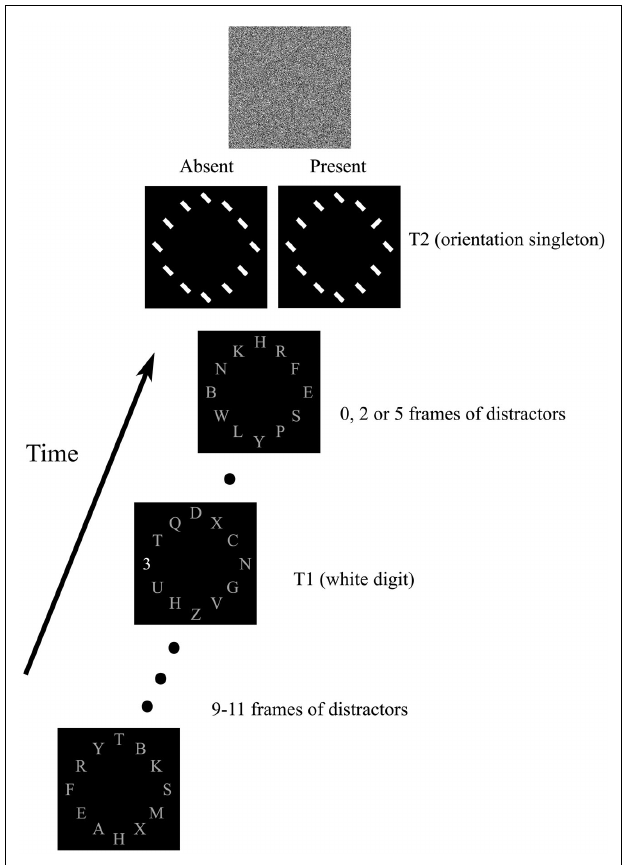
FIGURE 1 | Sequence of events in the experiment. Twelve streams of gray capital letters were presented on a virtual circle.T1 was a white digit (shown at 6 o’clock in the example).The array of tilted white bars would sometimes contain an orientation singleton (T2). See text for additional